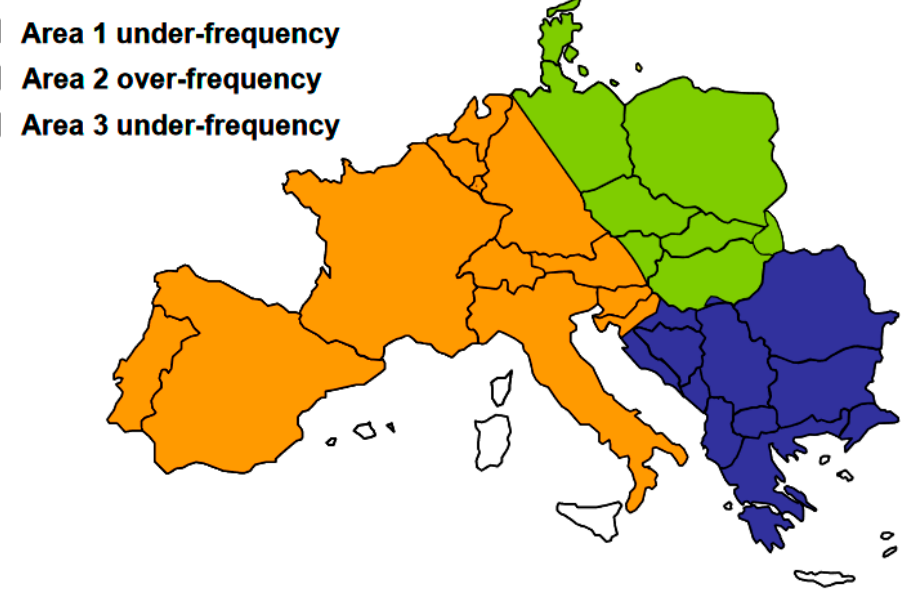
Figure 4. Schematic map of ENTSO-E (former UCTE) area split into three areas on 4 November